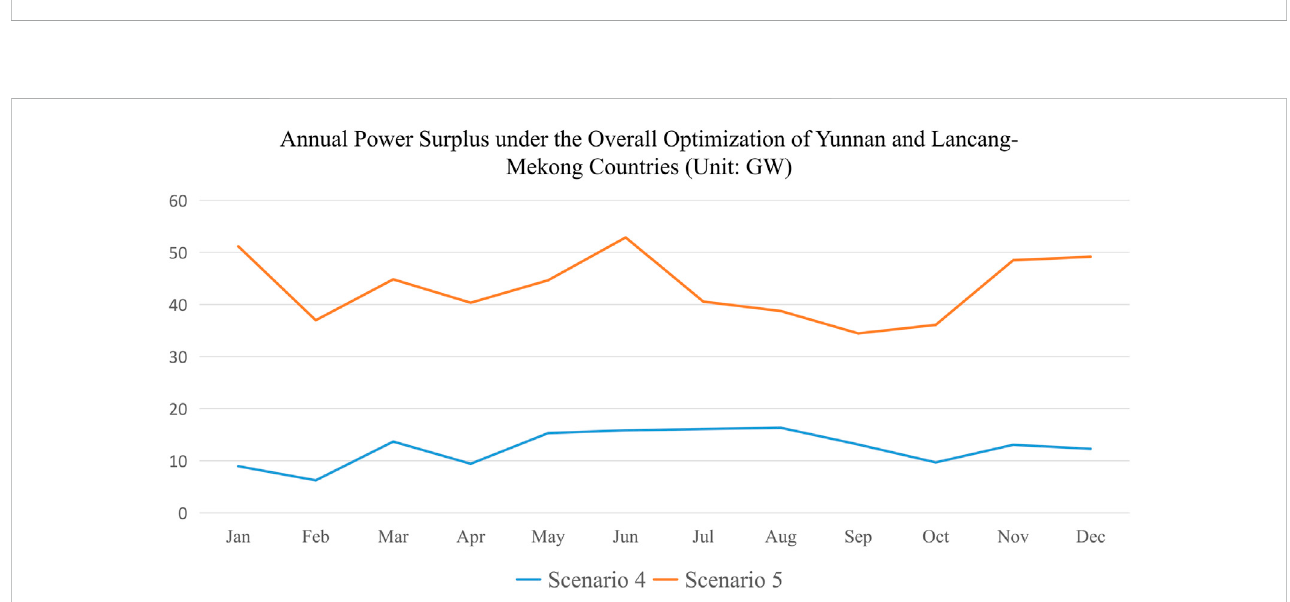
FIGURE 10 Annual power surplus under the overall optimization of Yunnan and Lancang- Mekong